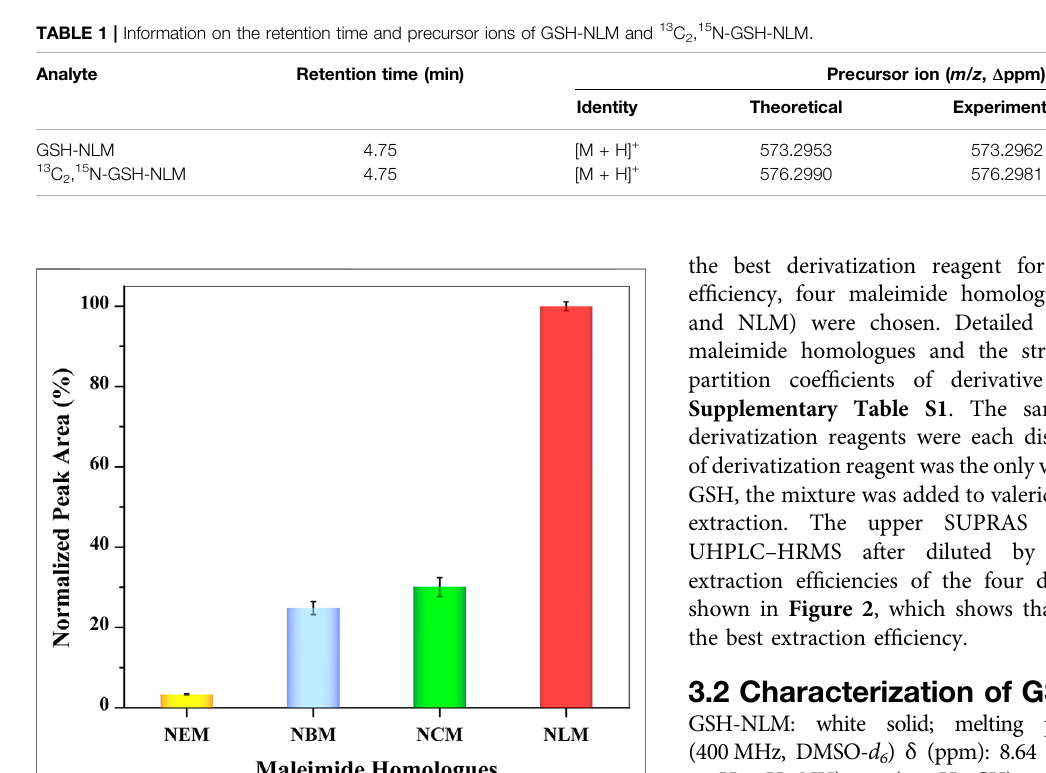
Frontiers in Chemistry |